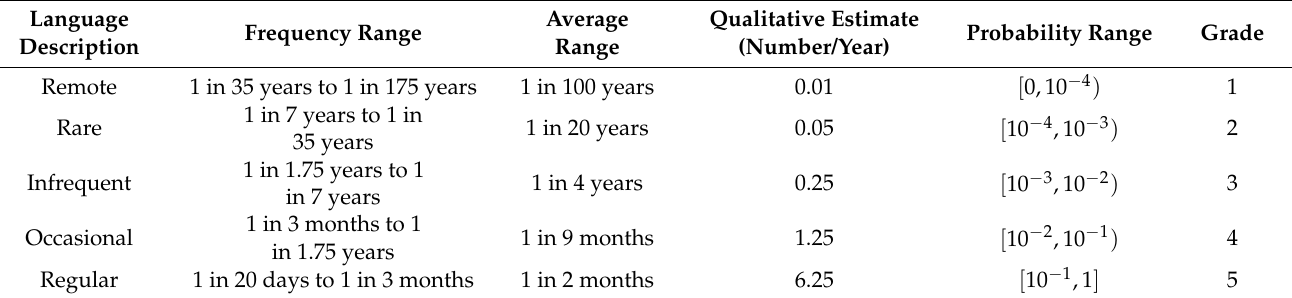
Table 3. Probability level of safety behavior risk of the transportation